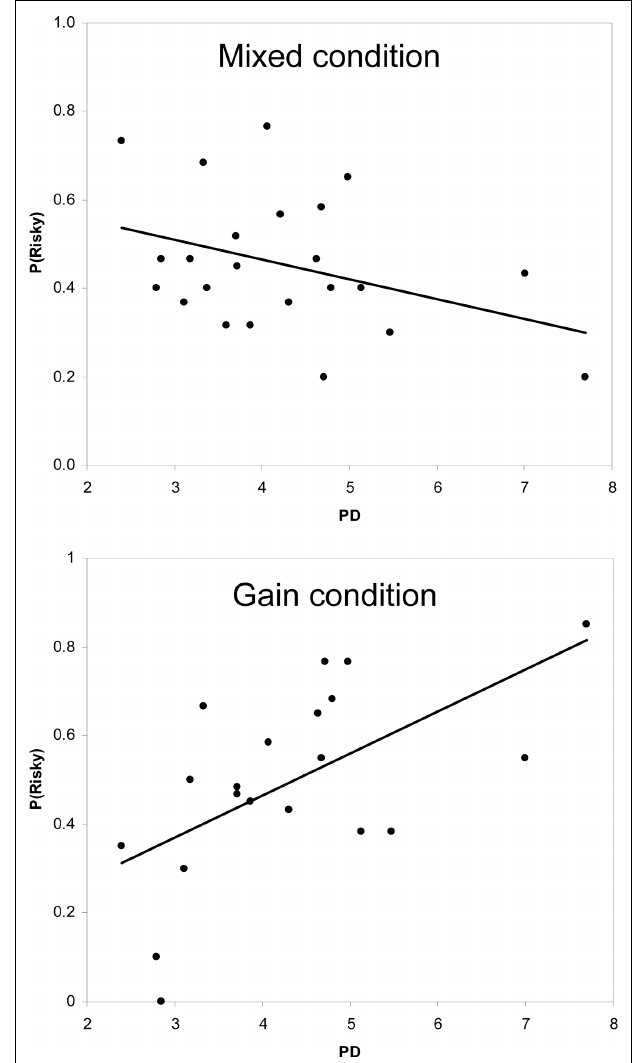
FIGURE 3 | Scatter plot and regression lines of the proportion of risky selections across trials by pre-task PD in Study 2.Top: Mixed condition. Bottom: Gain